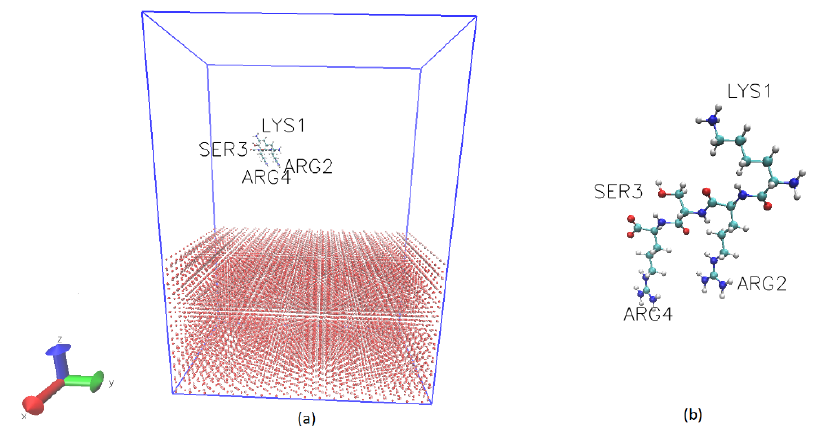
Figure 9. Snapshots of the initial geometry of the simulated system: ( a ) The left snapshot shows the TiO 2 crystal structure and the KRSR peptide, without the water molecules, the blue box represents the periodic boundary; ( b ) The right snapshot shows the initial KRSR peptide geometry. Color code: oxygen, red; nitrogen, dark blue; carbon, cyan; titanium, ochre; hydrogen, gray. Visualization was done with VMD 1.9.3 in CPK representation.